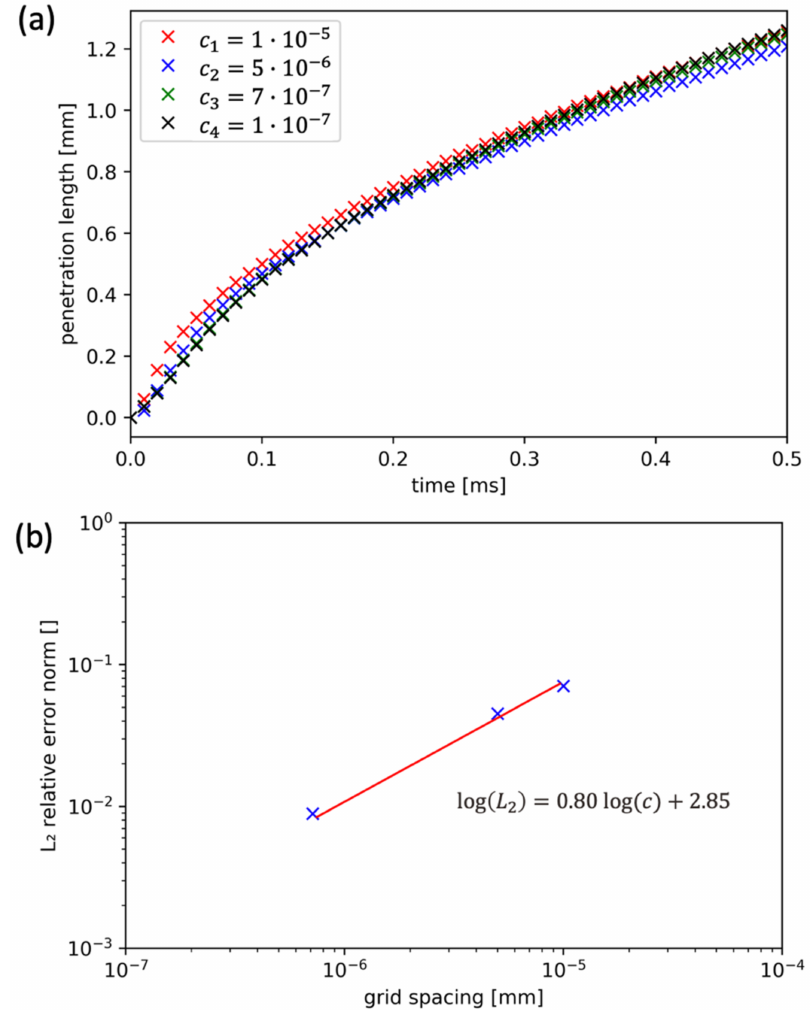
Figure A2. Illustration of convergence with respect to grid spacing using the simulation setup for the capillary intrusion test of water into parallel plates. The figure presents the effect of the grid spacing on ( a ) the curves of time-dependent penetration length and ( b ) the corresponding L 2 diagram with a convergence order of